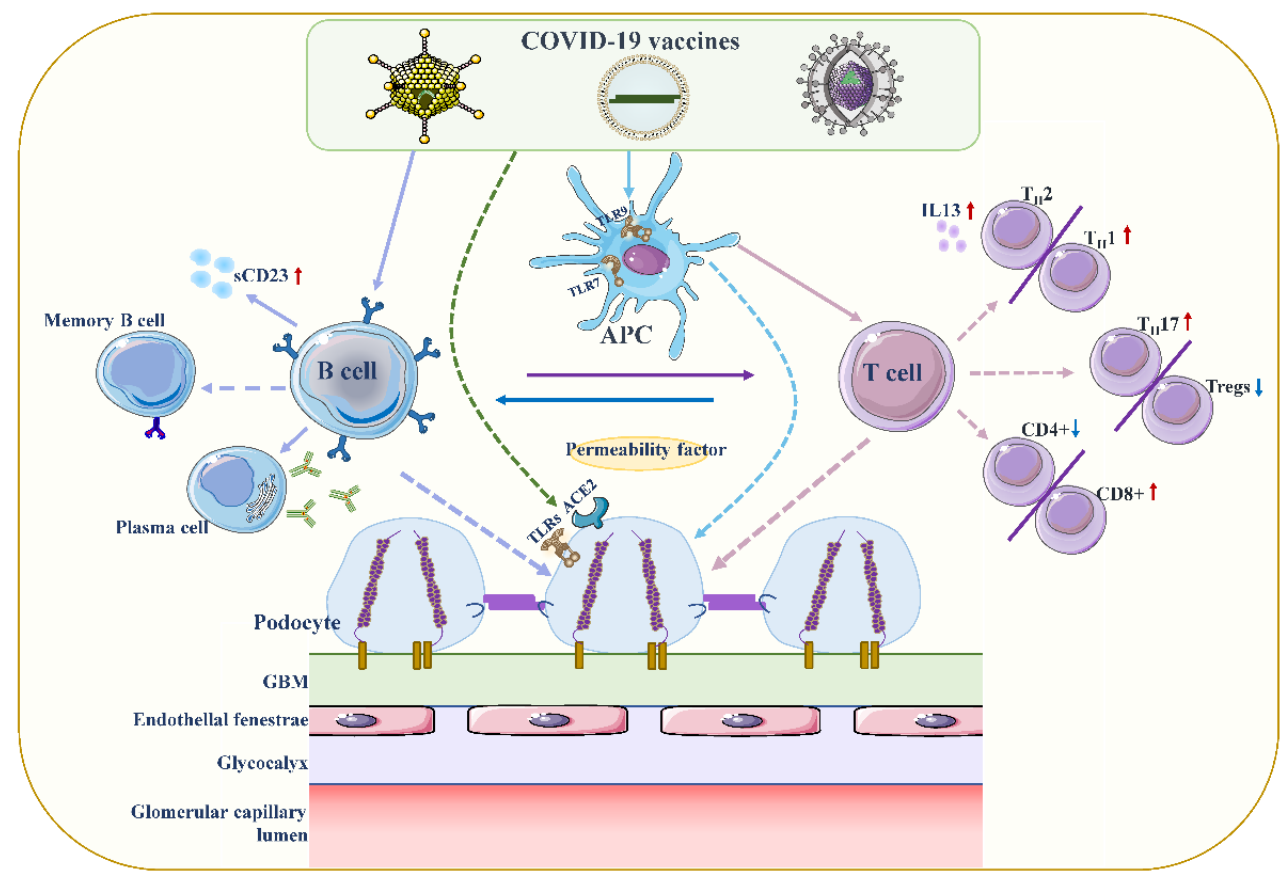
Figure 2. Proposed mechanisms of podocyte injury caused by COVID19 vaccination. Vaccination stimulates antigen-presenting cells (APCs) and B cells, which in turn activate T cells through antigen presentation and cytokine production. A decrease in CD4+ T helper (Th) cells is associated with the prevalence of CD8+ cytotoxic T cells, and an imbalance between Th2 and Th1 cells is associated with an increase in Th2-specific interleukin-13 (IL-13) production, and Th17. In contrast to increased cellular activity, the frequency and function of regulatory T cells (Tregs) decreased. Permeability proteins, such as cytokines and autoantibodies, can directly affect podocytes, leading to loss of foot processes and disruption of the glomerular permeability barrier. In addition, the vaccine can also affect podocytes through specific toll-like receptors (TLRs), and angiotensin conversion enzyme 2 (ACE2). The figure refers to the pathogenesis of minimal change disease by Vivarelli et al [53].